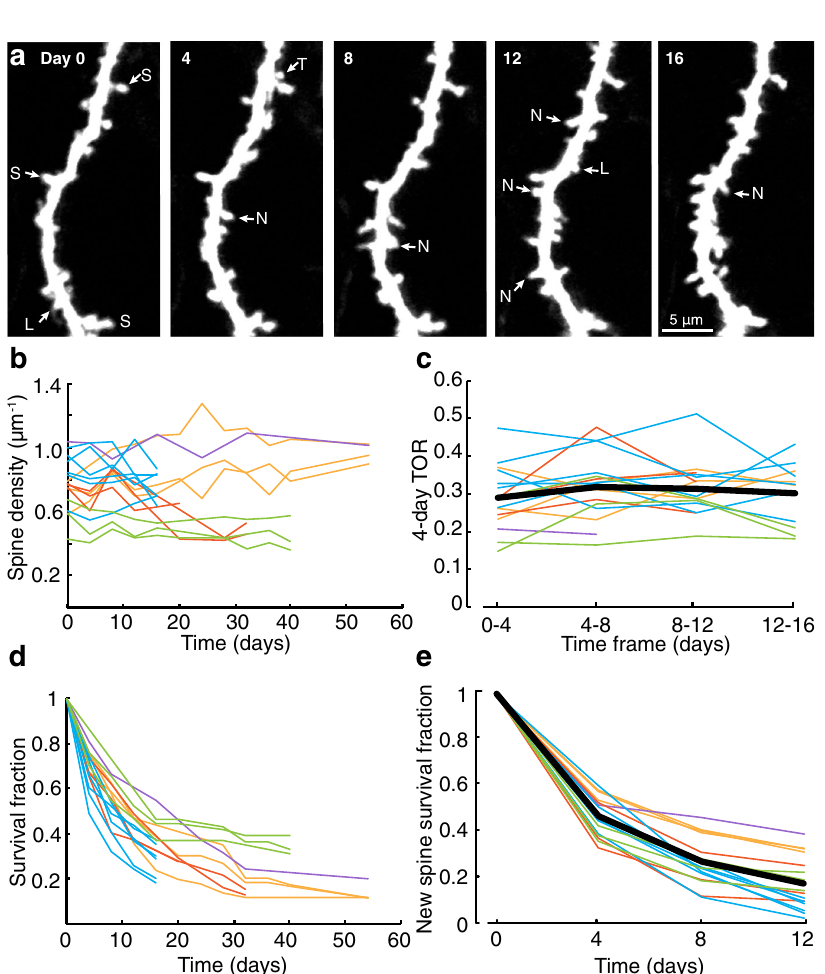
Fig. 3 Spines on VIP neurons are dynamic. a Time-lapse images of a VIP-GFP dendritic segment in L1. A number of spine types can be detected, varying from stable (S), new (N), and lost (L) spines. Some new spines are lost immediately (transient, e.g. T) b Spine densities over time. Lines correspond to individual dendrites. Lines with the same color belong to the same mouse. c The 4-day spine turnover ratio (4-day TOR): the fraction of spines that is gained and lost between two imaging sessions. d The survival fractions of spines that were observed on the fi rst day of imaging (day 0). e The survival fractions of newly formed spines. Thick black lines in ( c ) and ( e ) represent